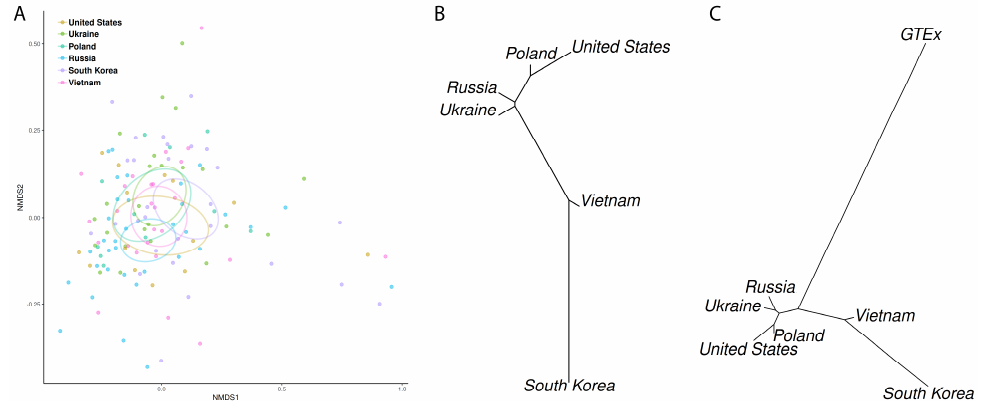
Figure 3. Gastric cancer microbiome profiling in function of the host geographical origin. ( A ) non-metric multidimensional scale (nMDS) plot for the weighted UniFrac distances and PERMANOVA analysis (stress = 0.17; r2 = 0.05; p ~0.054) between the geographic groups in the cancer cohort (same colors as in Figure 1). ( B ) Neighbor-joining tree of the mean weighted UniFrac distances between the